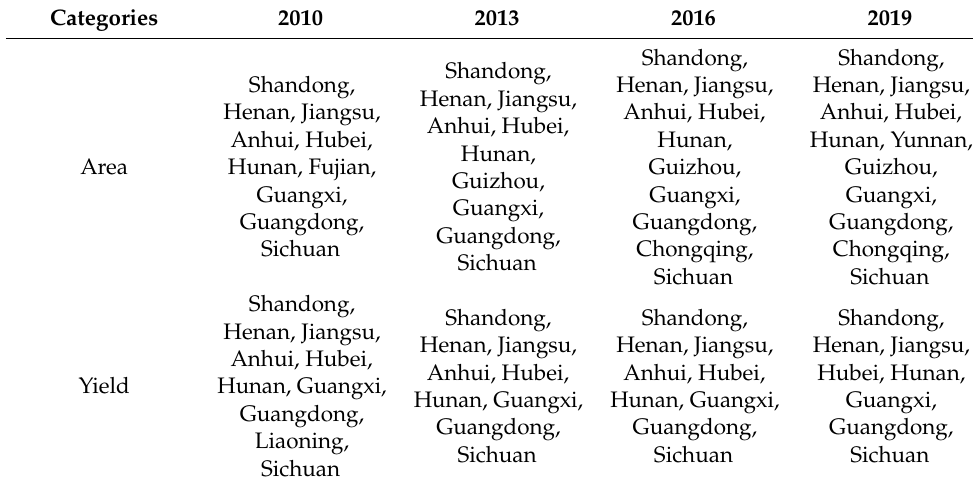
Table 4. Change in “high-high” type of